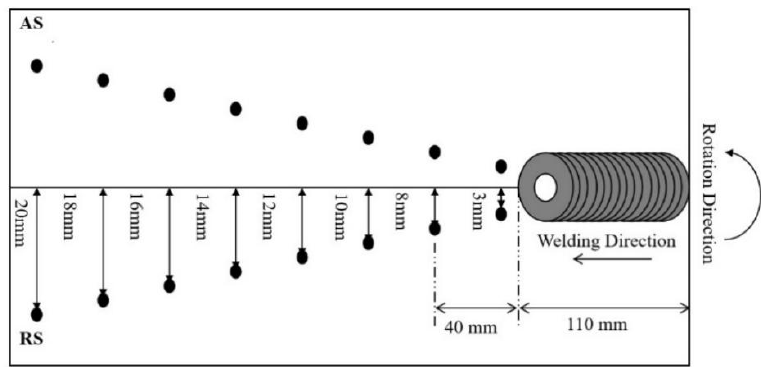
Figure 3. Distribution of temperature measurement points.